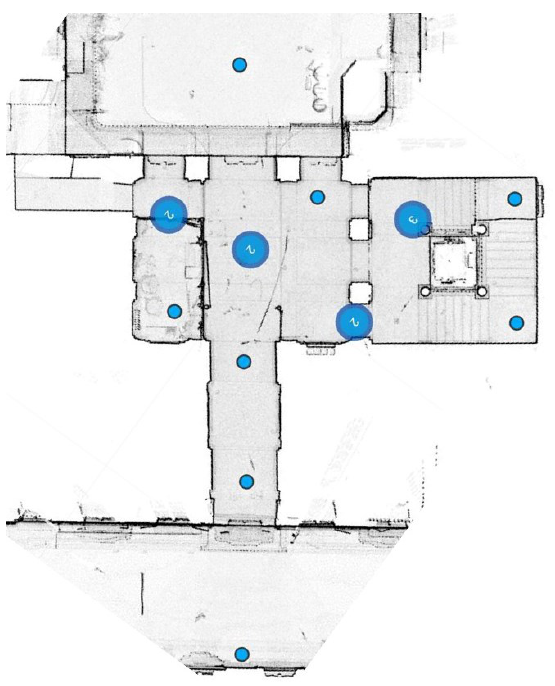
Figure 9. Location of scan points. Scanning: M. C. López González. Processing: F. Natta